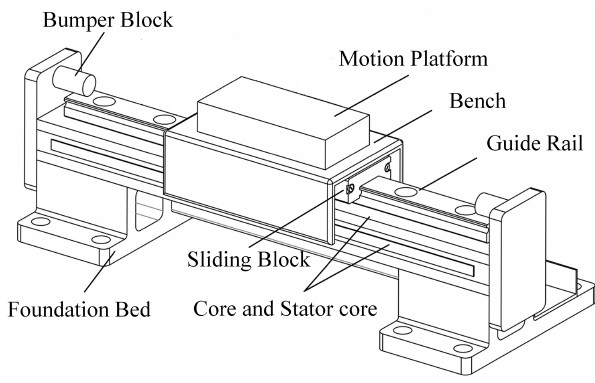
Figure 1. Permanent magnet linear motor structure